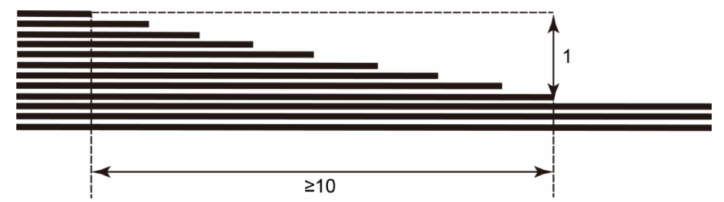
Figure 14. Recommended slope of transition region.